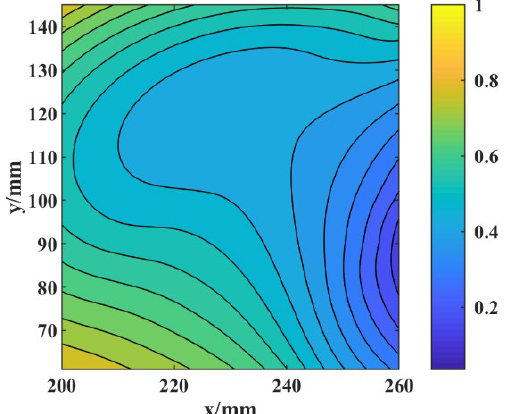
Figure 8. Distribution diagram of dexterity index.